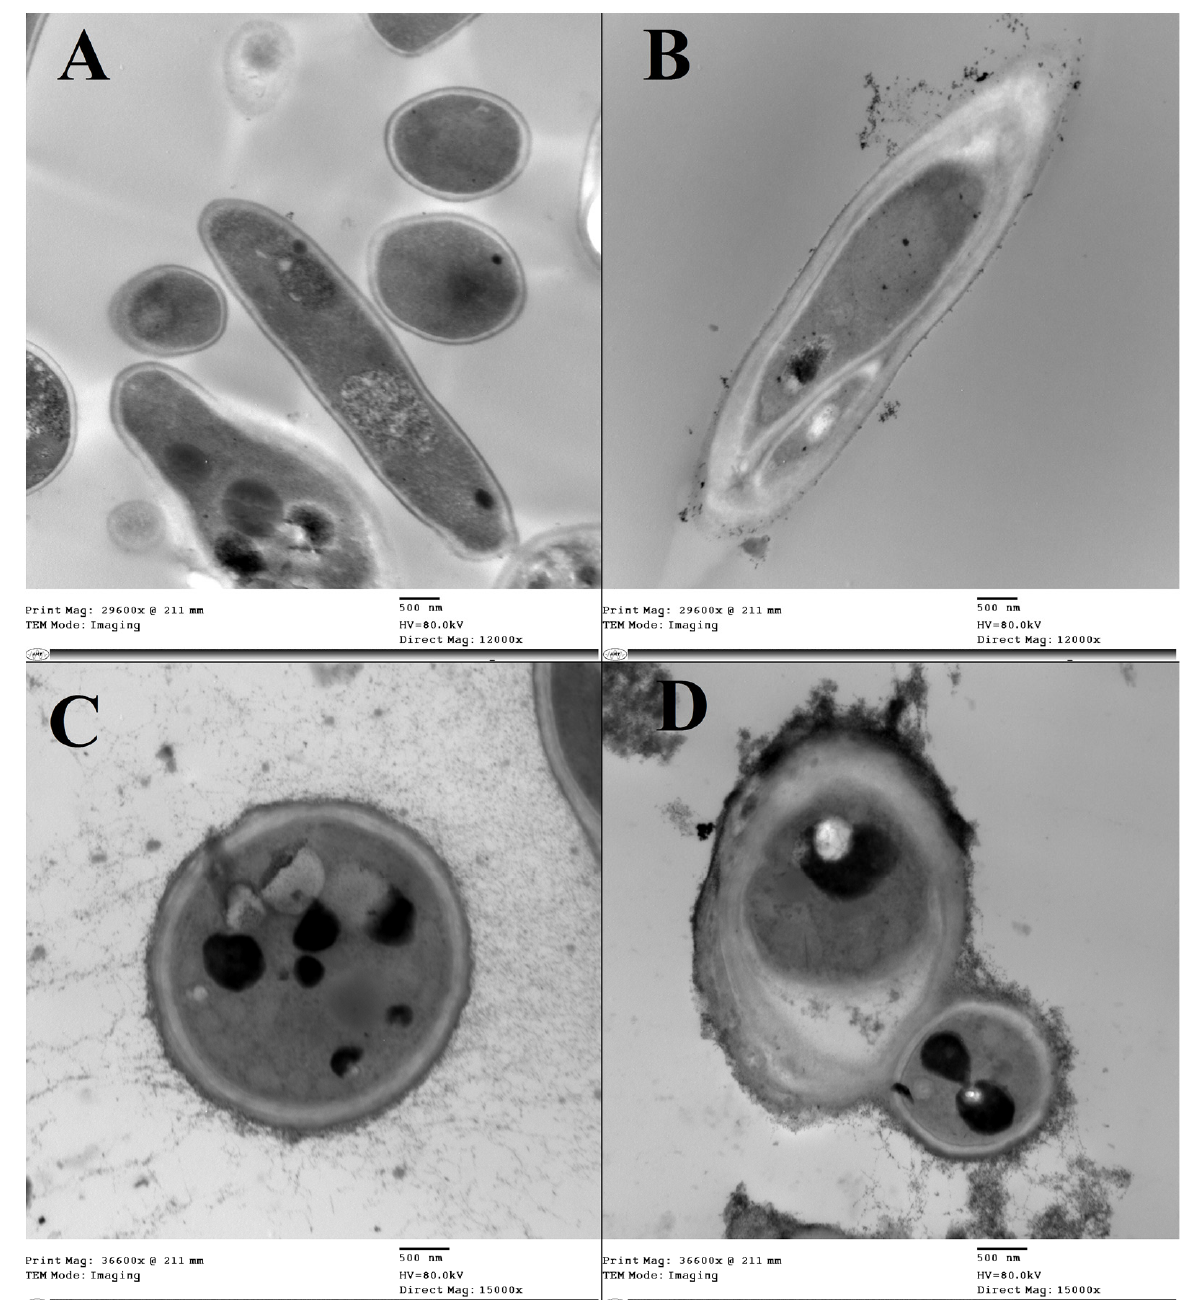
Figure 10. TEM micrographs showing the ultrastructure alternations in fungal spores upon exposure to the biogenic TeNP produced by Gayadomonas sp. TNPM15. ( A ) Untreated F. oxysporum (Control), ( B ) TeNPs-treated F. oxysporum , ( C ) Untreated A. alternata (Control), ( D ) TeNPs-treated A. alternata .